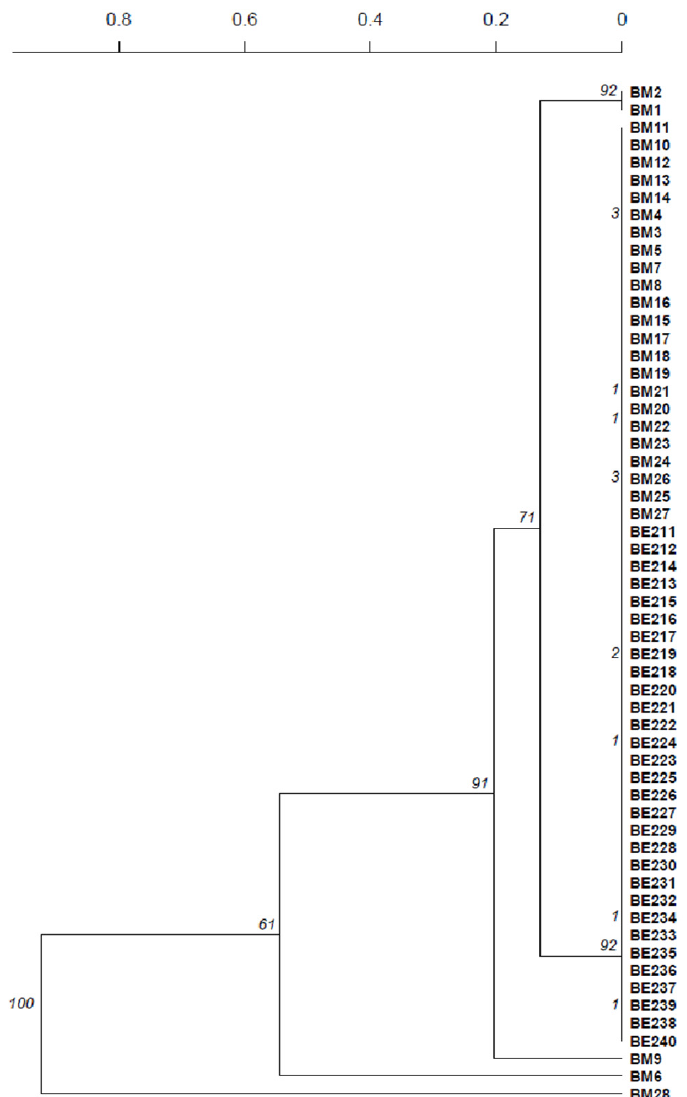
Figure 5. Dendrogram presenting the genetic distance between the isolates from the blank modality based on the microsatellite profiles. Isolates from fermentation are represented by the letters BM or BE, corresponding to middle or end of the blank fermentation, respectively, followed by the number of the isolate. Scale at top represents genetic distance.